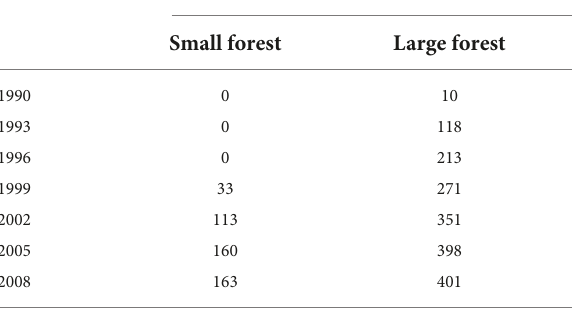
TABLE 4 Estimated long-term “low-risk” NZUs per hectare for owners of small and large forests, by year of planting.